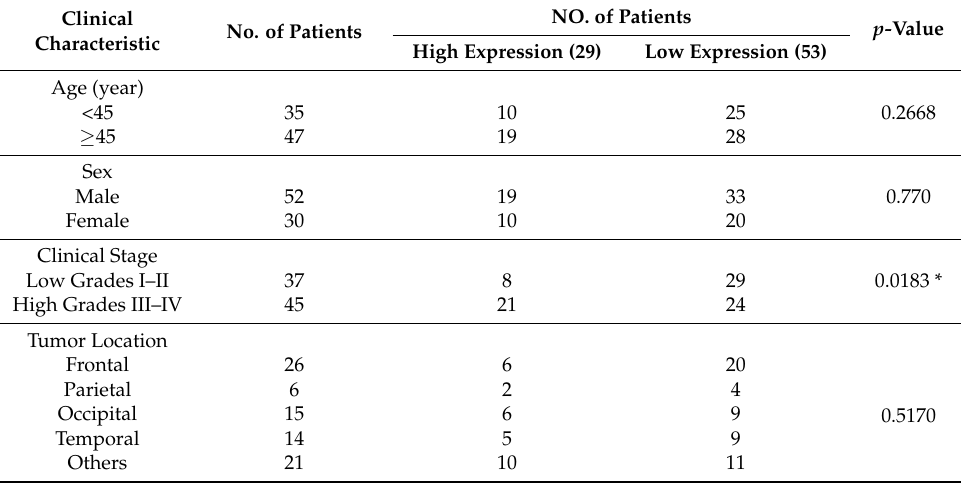
Table 1. Correlation between lncRNA ZEB1-AS1 expression and clinicopathological features of glioma patients.